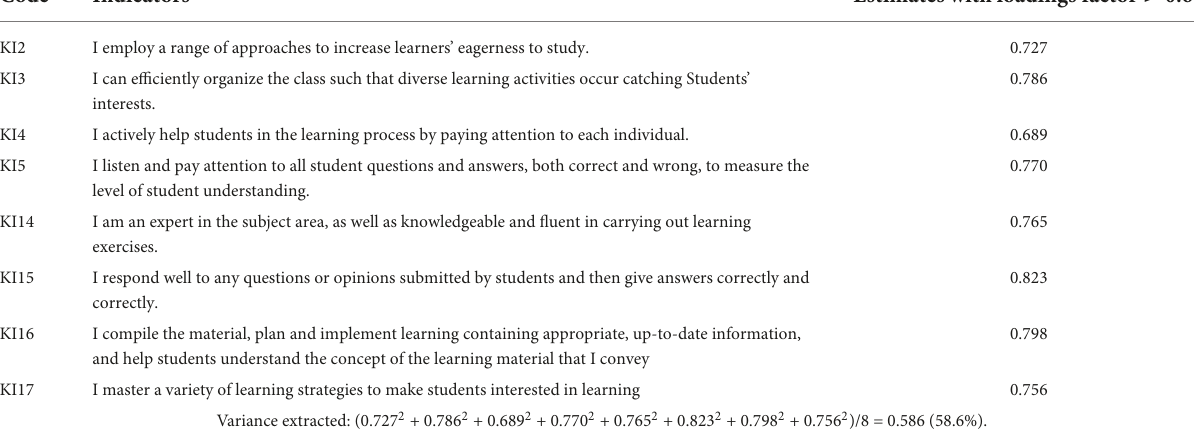
TABLE 5 Loading factor from indicators to scientific variables (pedagogical knowledge and content knowledge). Code